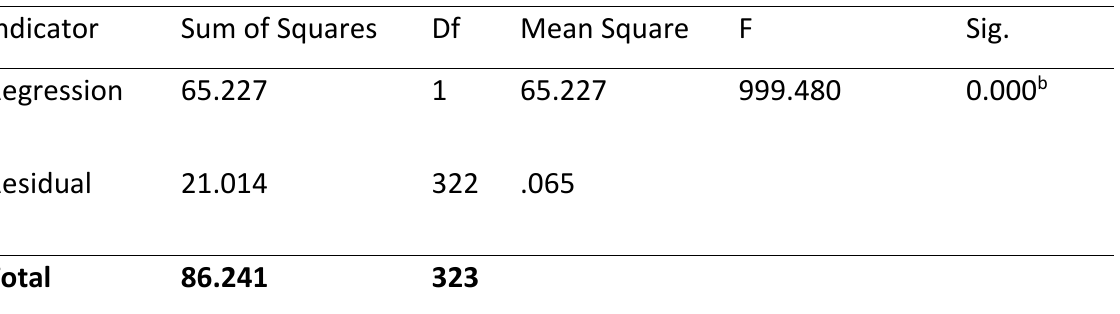
Table 5. Analysis of variance